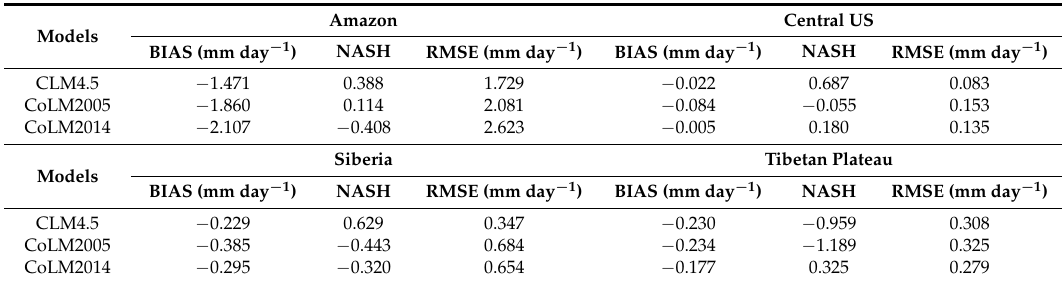
Table 2. Statistical summary of simulated runoff annual cycles.